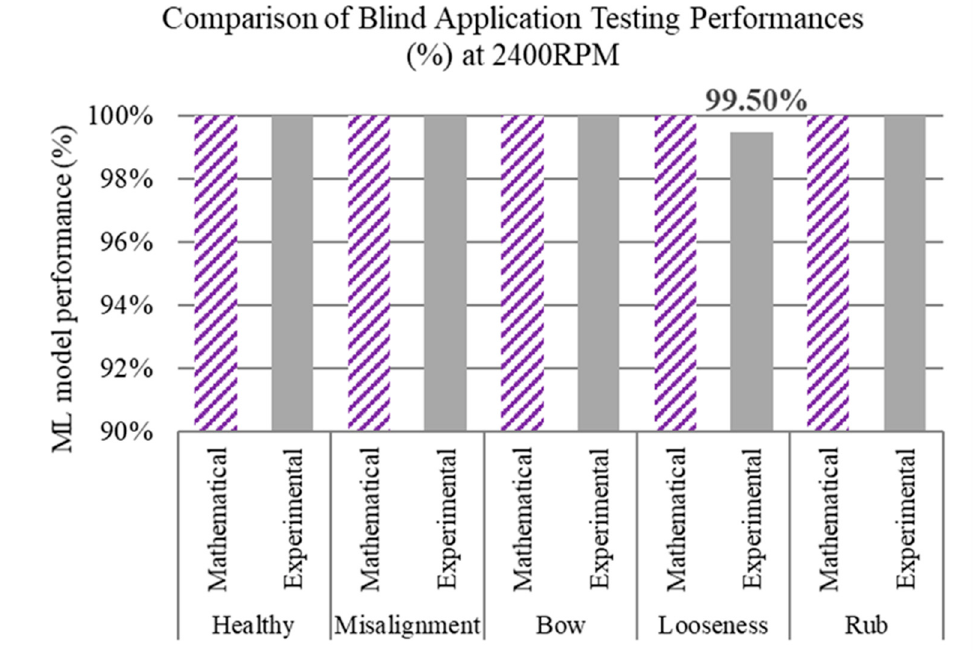
Figure 10. Comparison of performance (%) using experimental data and data generated in the FE model in the blind application of VML fault detection model at 2400 RPM.